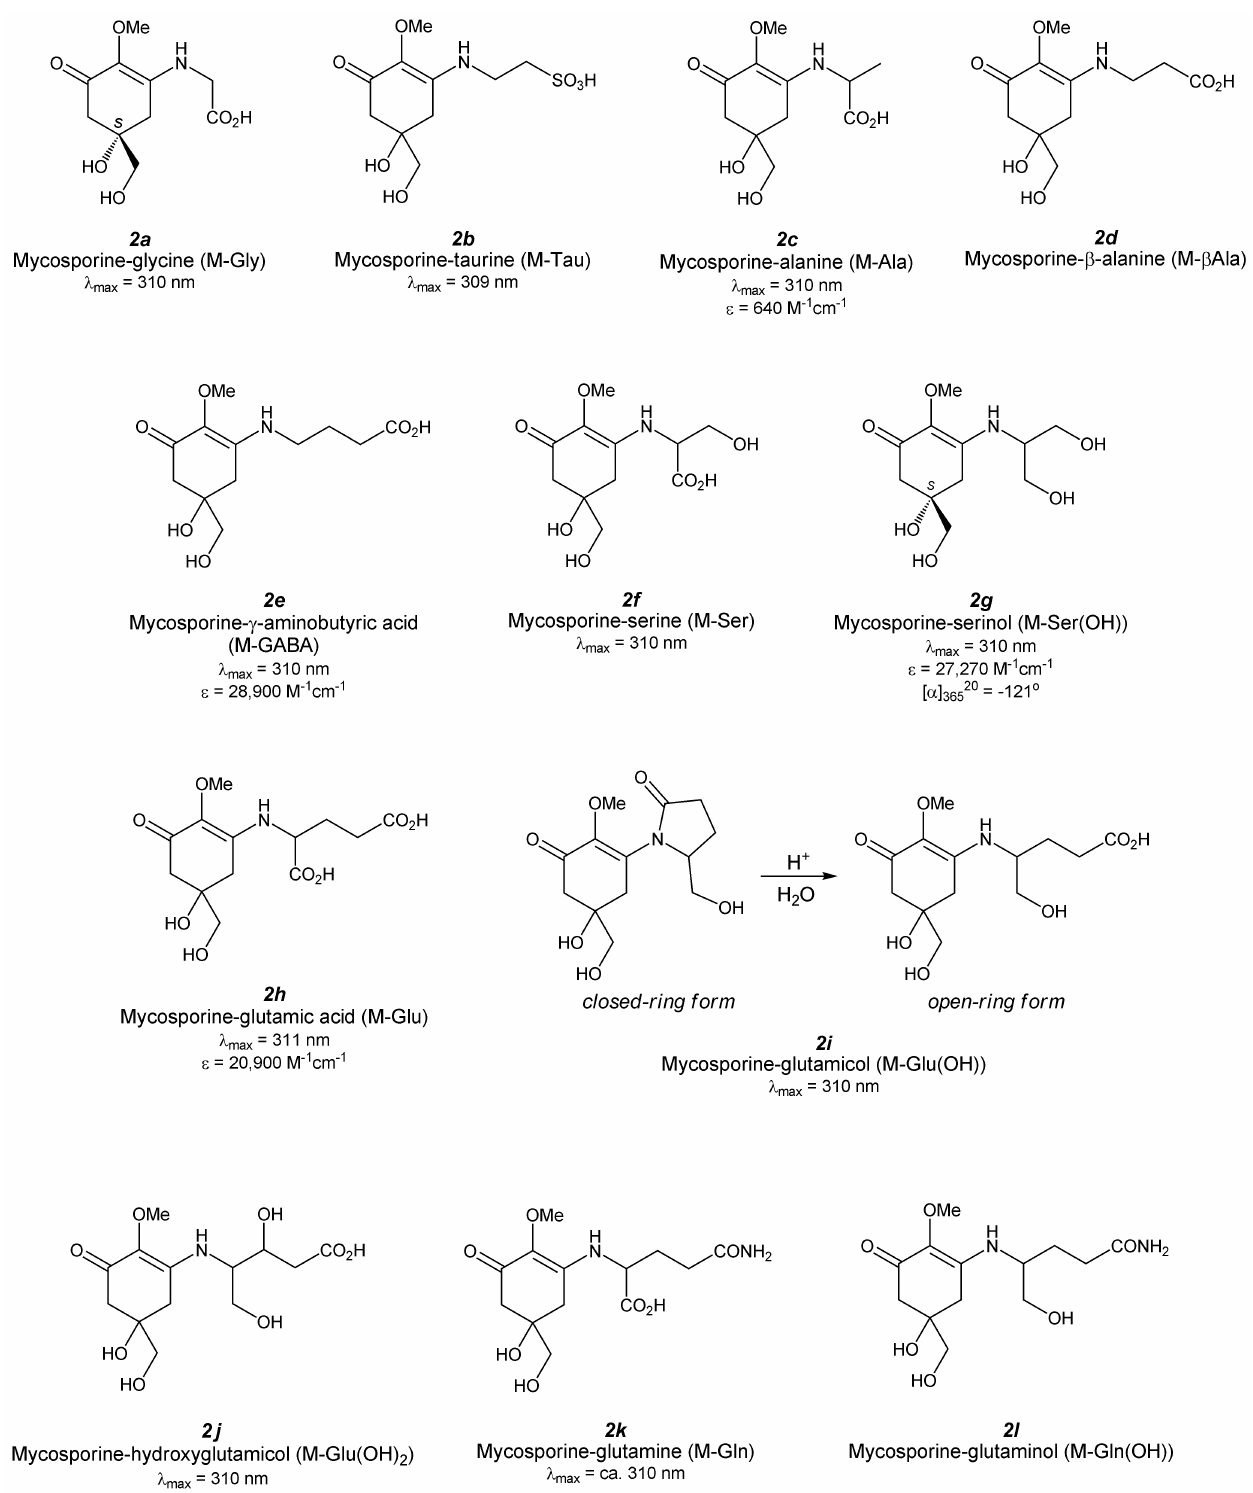
Figure 3. Chemical structure and spectroscopic properties of aminocyclohexenone-type MAAs. Abbreviations are shown in